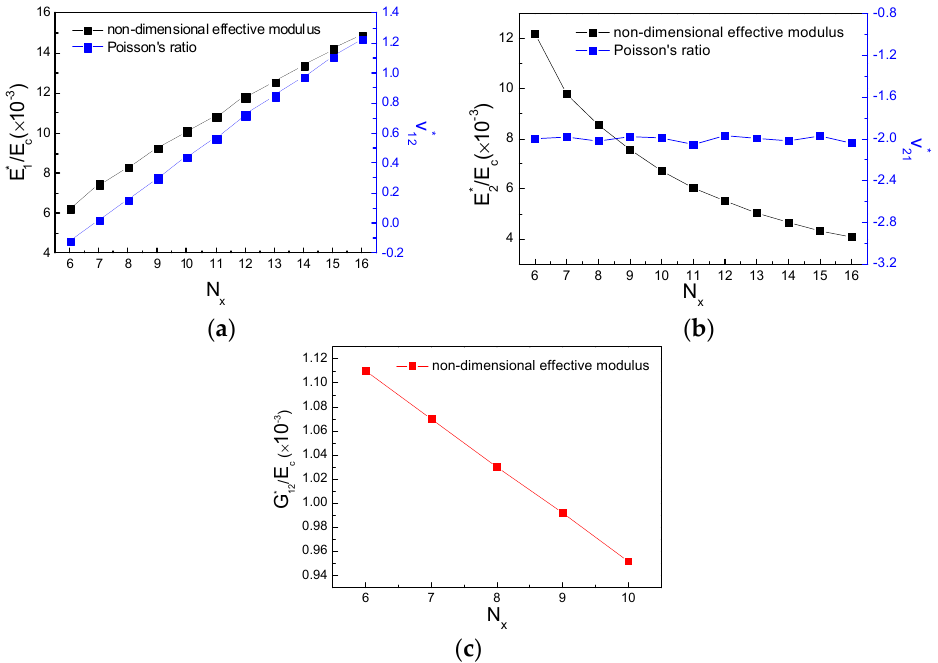
Figure 8. The number variations of star subordinate cell: ( a ) N x along x direction, ( b ) N y along y direction.